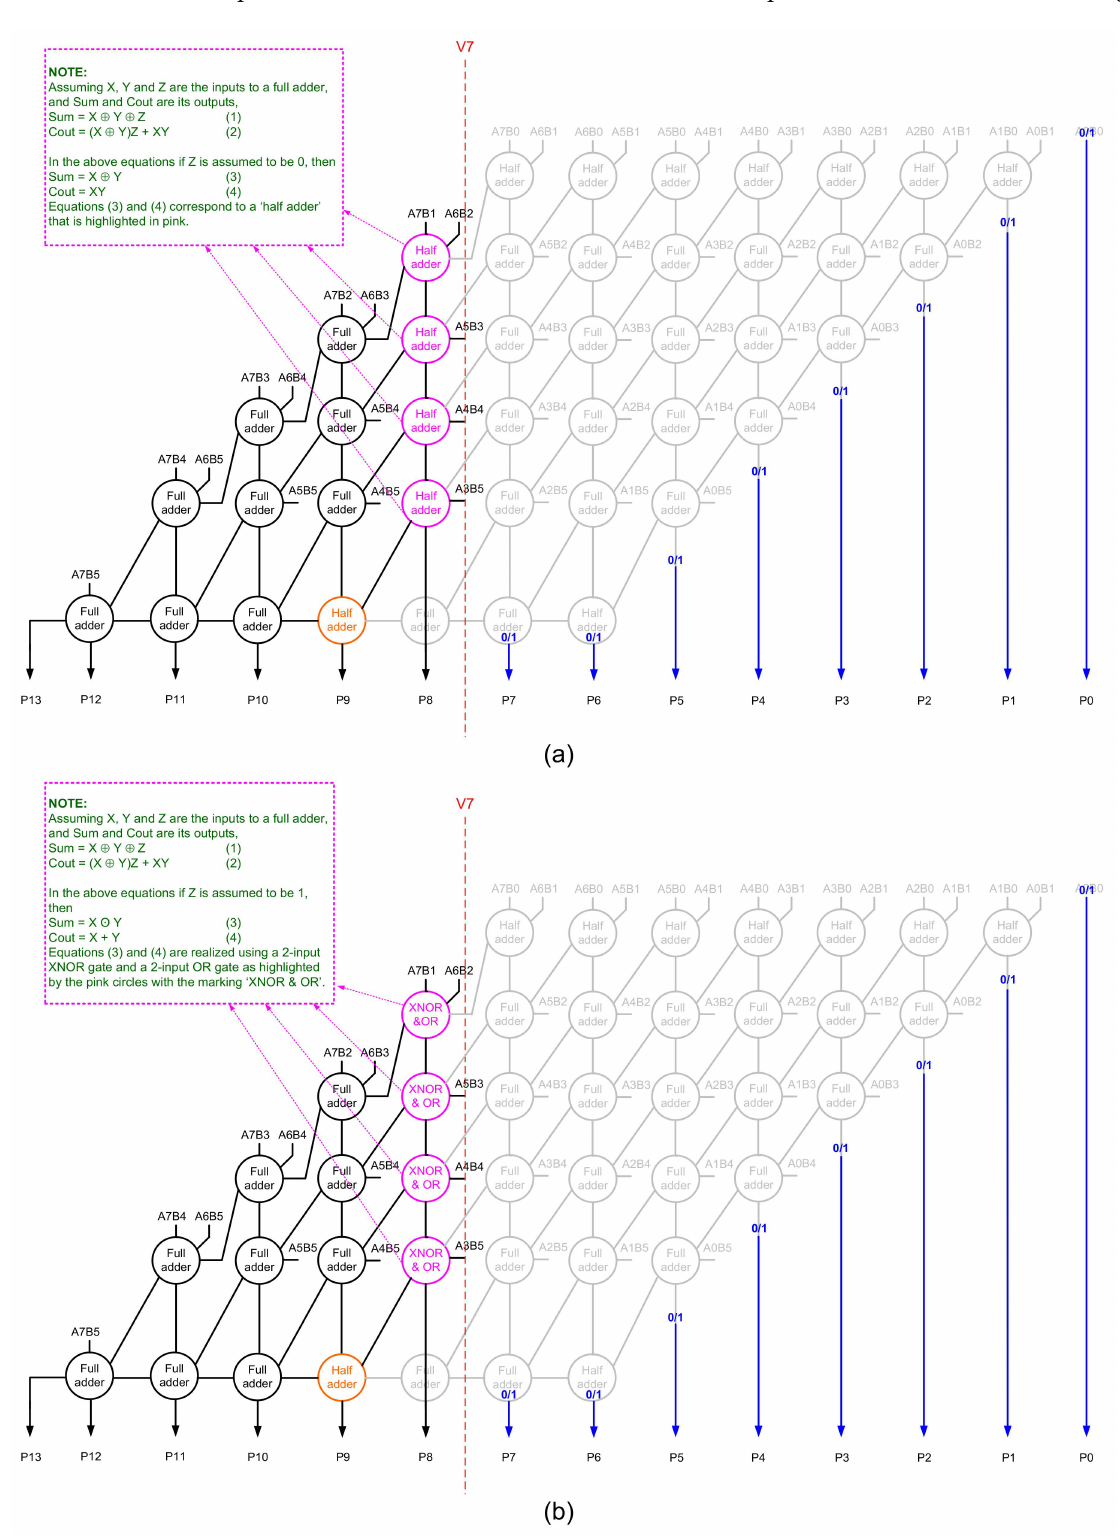
Figure 4. Logic optimization of an approximate array multiplier (obtained through vertical cut V7) based on the assignment of: ( a ) a 0 input assigned to the full adders highlighted in pink in the correct Figure 3a; ( b ) a 1 input assigned to the full adders highlighted in pink in the correct Figure